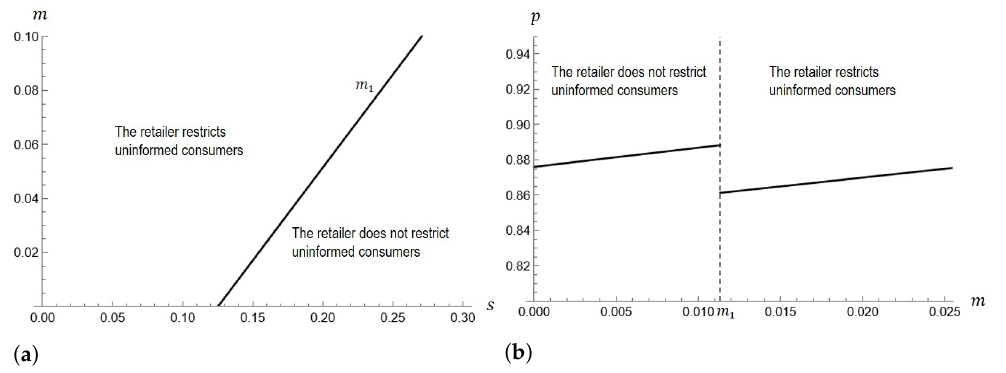
Figure 2. Seller’s optimal decision in scenario NR ( c = 0.4, θ = 0.6, λ l = 0.4, λ h = 0.5, β = 2, h = 0.048, s = 0.1, k = 0.0002); ( a ) retailer’s restricting decision in scenario NR; ( b ) the optimal price changes in scenario